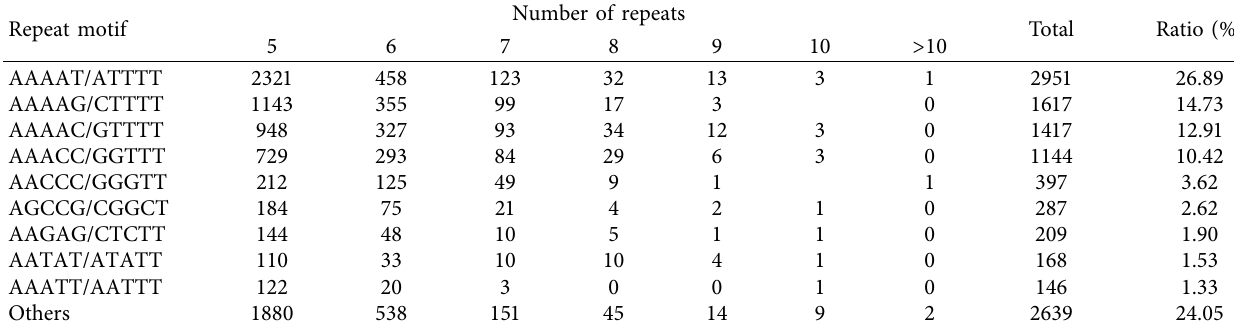
Table 8: Statistics of pentanucleotide 10, 975